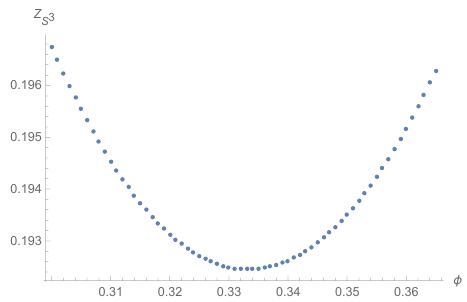
Figure 4. Plot of Z ( A 1 ;D 3 )+ (cid:12) vs. r (cid:30) after including the Monopole superpotential (cid:14)W = (cid:12) M . S 3